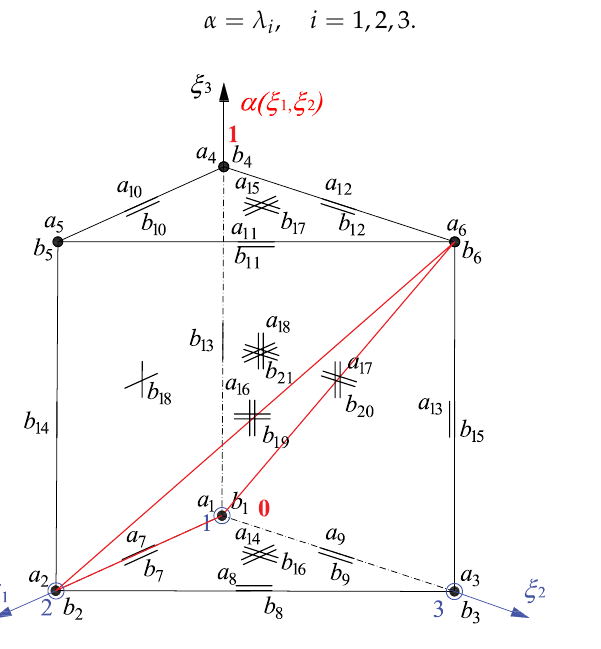
Figure 4. The blending function for an example of the principal transition geometry